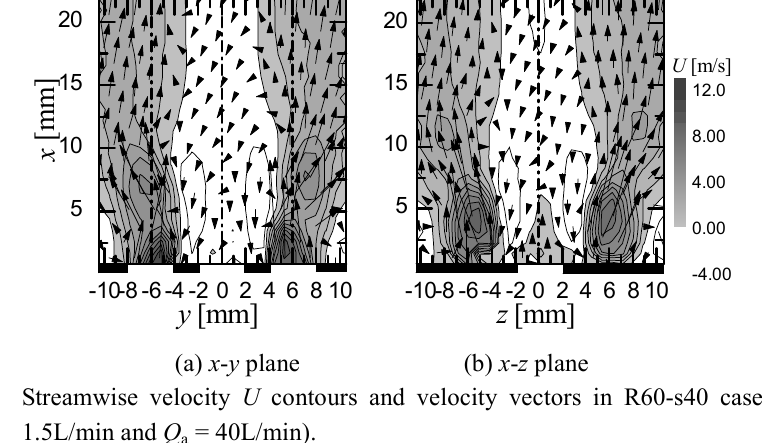
Fig. 8 Streamwise velocity U contours and velocity vectors in R60-s20 case ( Q = 40L/min). 1.5L/min and Q a